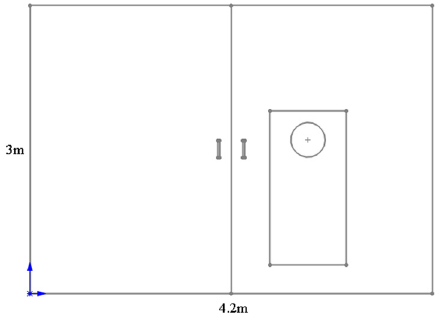
Figure 1. Automatic air door with personnel door.